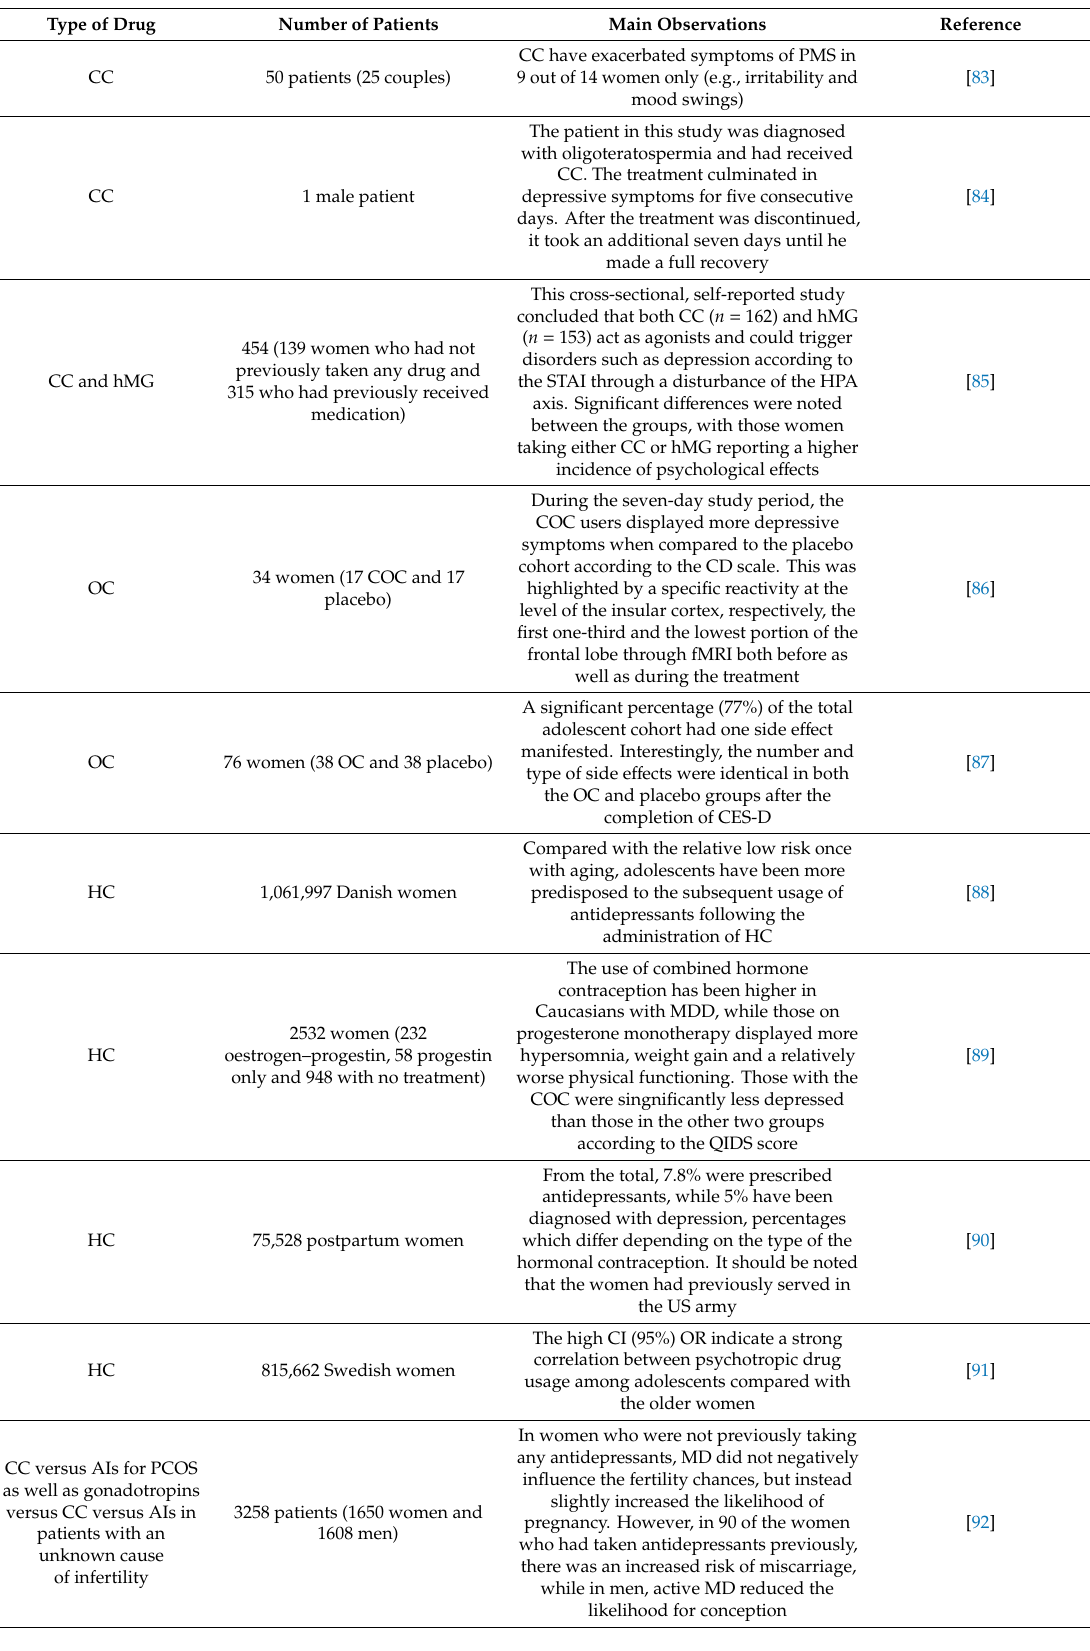
Table 2. Infertility drugs with a known e ff ect to induce pronounced mood fluctuations as a side e ff ect. Type of